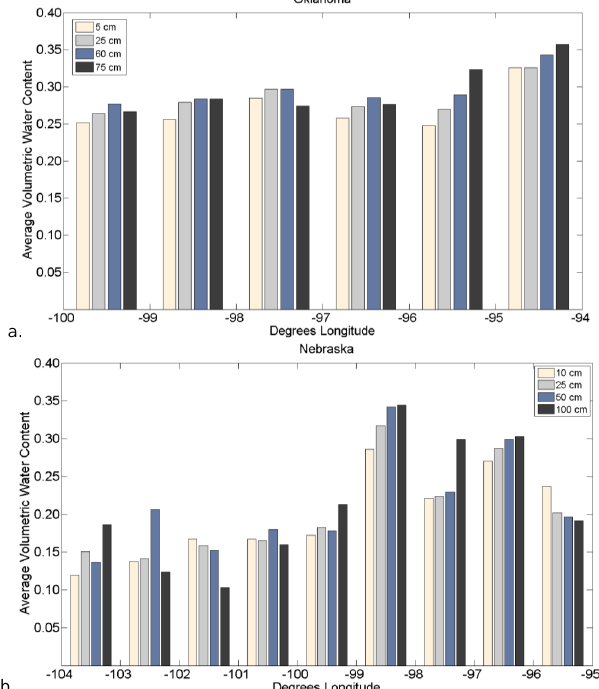
Figure 3 . Oklahoma Mesonet (a) and AWDN (b) stations are binned by the station's longitude. Bar graphs show the average volumetric soil water content for each bin at each measurement depth.